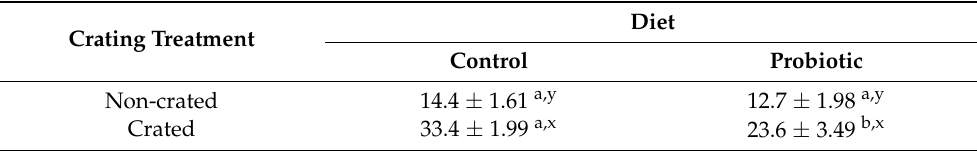
Table 3. Mean ( ± SEM) serum corticosterone levels (ng/mL) where interaction between diet and crating treatment were significant in ducks on day 21.